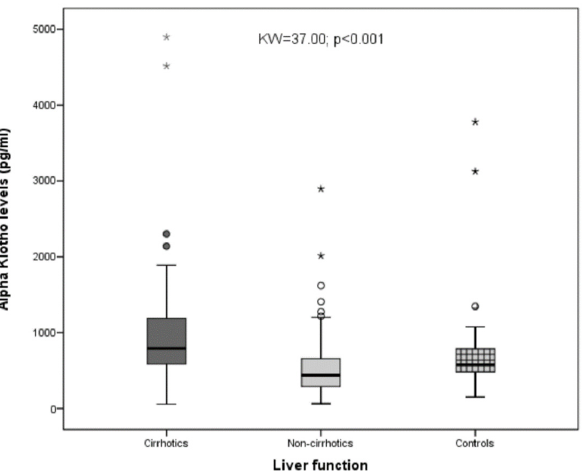
Figure 1. Differences in the serum Klotho values among the cirrhotics, non-cirrhotics, and healthy controls. As shown, statistically significant differences were observed when the three groups were compared (KW = 37.00; p < 0.001), * and ° = represent extreme values. Klotho was significantly related to prothrombin activity (with ρ = − 0.39 and p < 0.001), albumin (with ρ = − 0.15 and p = 0.047), and bilirubin (with ρ = 0.26 and p < 0.001) but not to serum creatinine (with ρ = − 0.03 and p = 0.72; NS). Marked differences were observed when Klotho was compared among the three Child’s groups (with KW = 15.96 and p < 0.001; Figure 2), and the patients belonging to the Child’s B or C groups showed significantly higher Klotho values (Z = 3.11; p = 0.002) than patients belonging to the Child A group. Klotho was also related to platelet count ( ρ = − 0.39; p < 0.001). Therefore, the Klotho values were higher among cirrhotics and were related to liver function impairment.